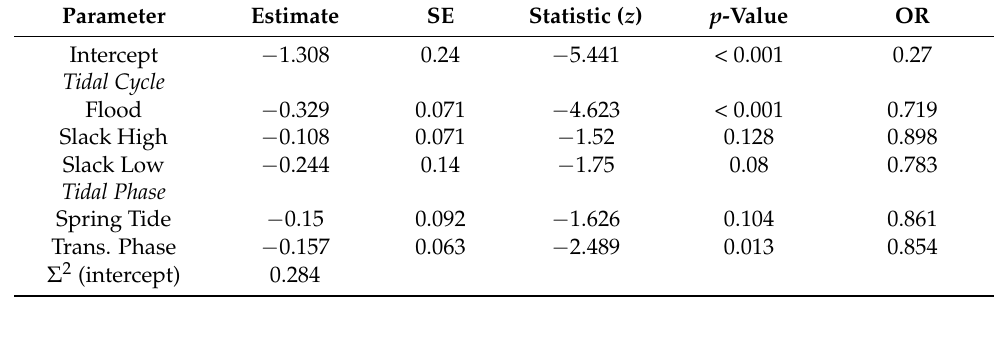
Table 5. Final model for Shannon Airport ( n = 8184 minICIs of which 1792 classified as foraging. Recorded by 6 different C-POD units). Estimates with standard errors (SE) and odds ratios (OR) of